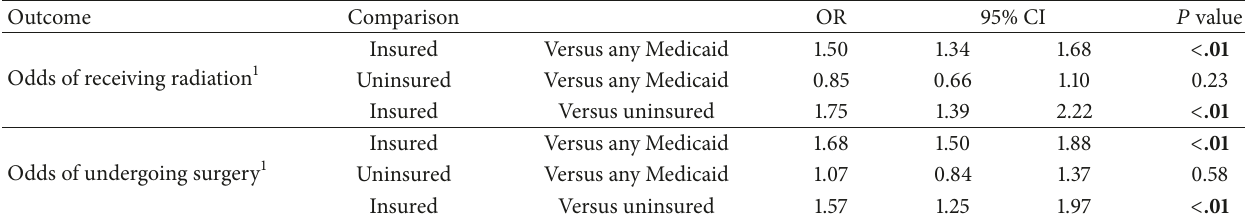
Table 2: Adjusted odds ratios for receiving radiation or surgery by insurance status.